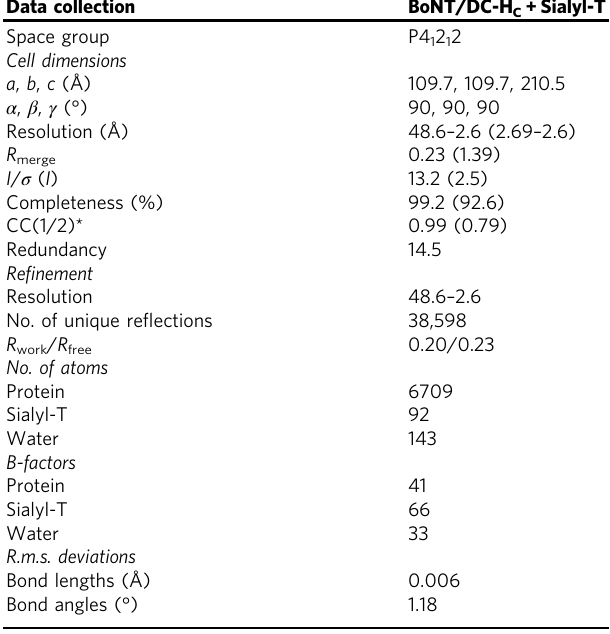
Table 1 Data collection and re fi nement statistics Data